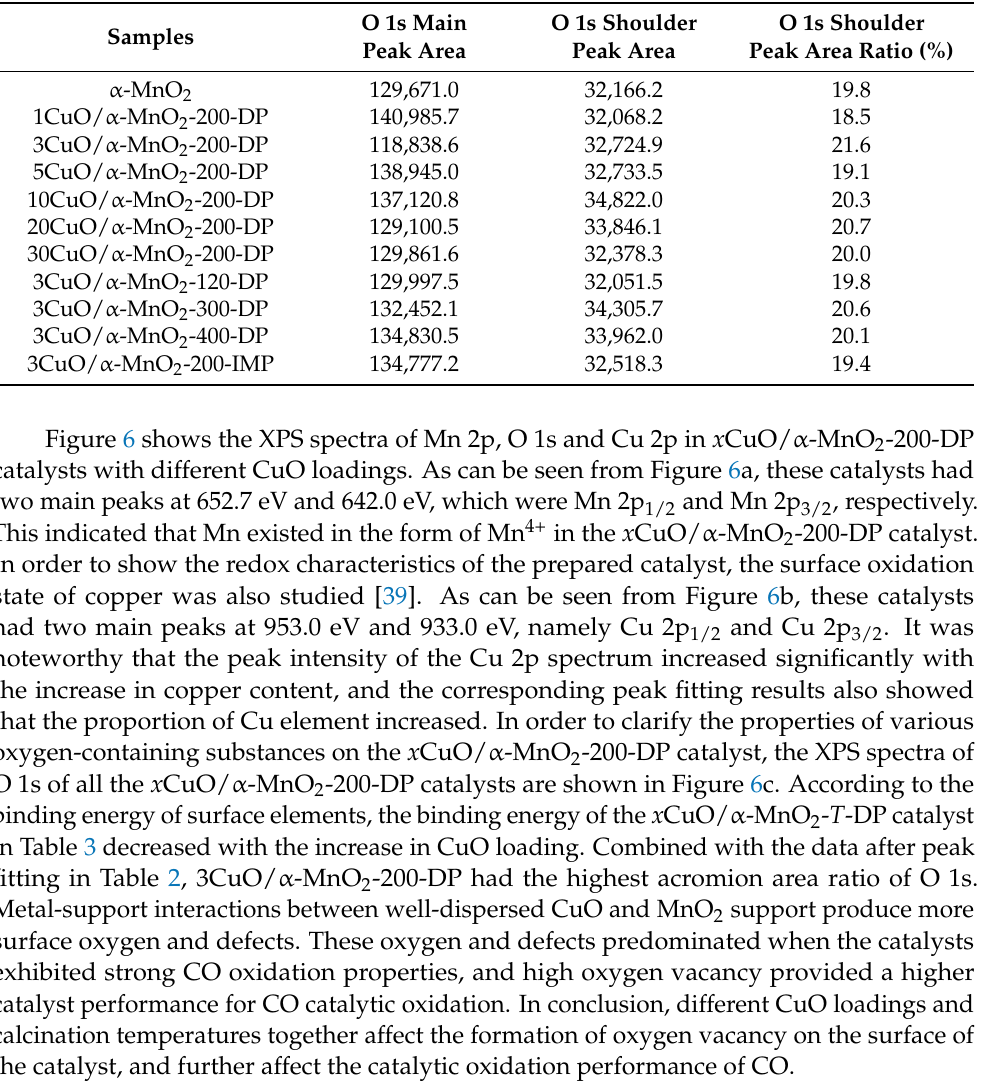
Table 2. O 1 s peak areas of the catalysts based on